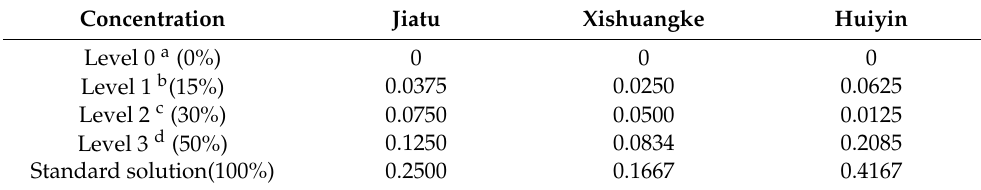
Table 3. Information about the concentration of each pesticide in the mixture. Concentration Jiatu